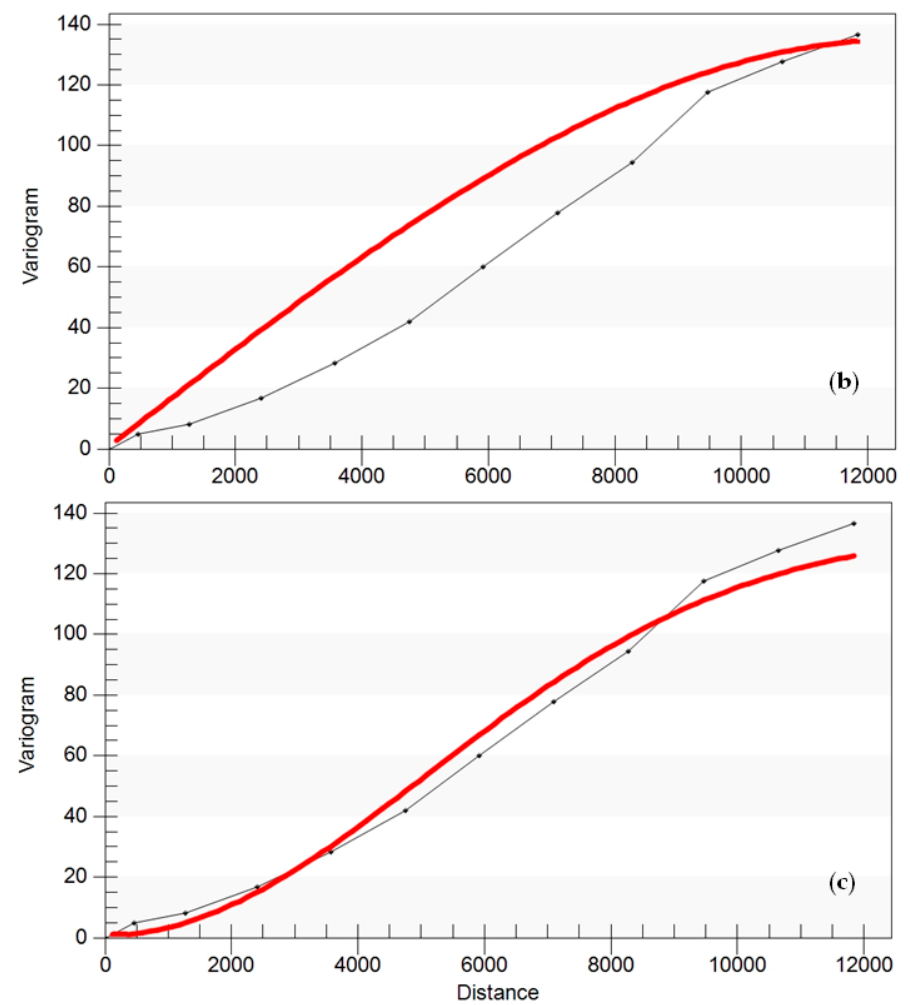
Figure 3. Experimental and fitted semivarigrams for the groundwater head level: spherical ( a ), exponential ( b ), and Gaussian ( c ).